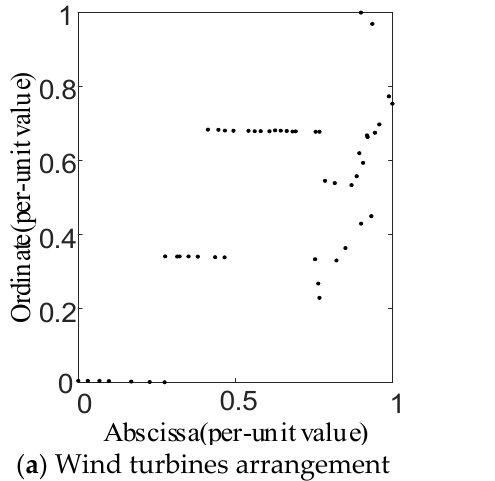
( b ) Zhushan wind farm Figure 11. Convergence curves of discrete particle swarm optimization algorithm. Micro siting of met mast is carried out in two zones of the island wind farm. The design of relevant parameters is referred in [26]. Firstly, Windsim software is used to sim- ulate spatial wind flow distribution by the CFD numerical method. Wind condition pa- rameters in the prevailing wind direction, including wind acceleration factor, turbulence intensity, inflow angle, and reduced wind speed considering wake effect, are obtained by gridding the calculation of the target area of the wind farm. Next based on obtained grid information, alternative wind monitoring points are screened out according to micro quantitative siting strategy of met mast. Finally, the optimal locations of met mast in each zone are obtained based on the calculation of siting evaluation index. The screening re- sults of alternative wind monitoring points are shown in Table 3. The optimal location of wind monitoring point is shown in Figure 12. The two optimal locations of met masts in respective zones are relatively consistent with the above two load centers based on REOF method, which verifies the representativeness of met mast in final selected position. To further prove the effectiveness of the proposed micro siting method, the met mast positions determined by proposed method (met mast at points P 1 , P 3 , corresponding lon- gitude, latitude are respectively 121°55’49.2 ″ E, 29°47 ′ 18.2 ″ N/121°56 ′ 50.3 ″ E, 29°47 ′ 13.4 ″ N) and common method based on engineering experience in [14] (met mast at points P 6 , P 7 , corresponding longitude, latitude are respectively 121°56 ′ 10.1 ″ E, 29°47 ′ 80.3 ″ N/121°56 ′ 59.6 ″ E, 29°48 ′ 17.4 ″ N) are respectively used as CFD simulation inputs, and esti- mated results and errors regarding the annual power generation of wind farms are shown in Table 4. It can be seen that taking met mast positions (P 1 , P 3 ) as input, the error of esti- mated power generation is the smallest. In addition, the error of estimated power gener- ation with two met masts is smaller, compared with one met mast. It is indicated that two